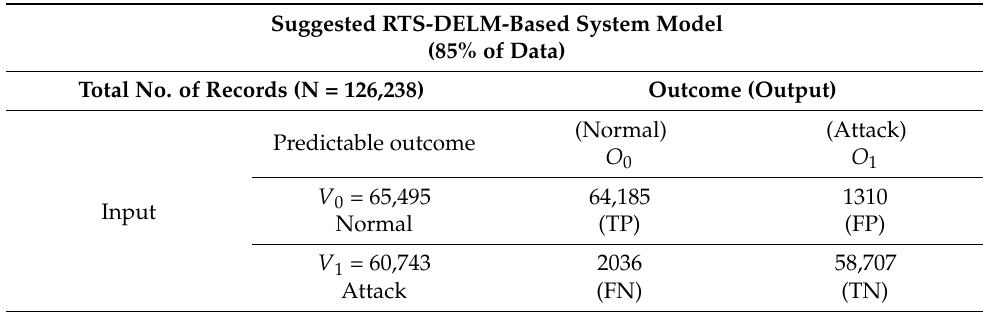
Table 1. Training of the proposed blockchain-based smart home network architecture for the estima- tion of intrusion with fused dataset empowered with Fused RTS-DELM.